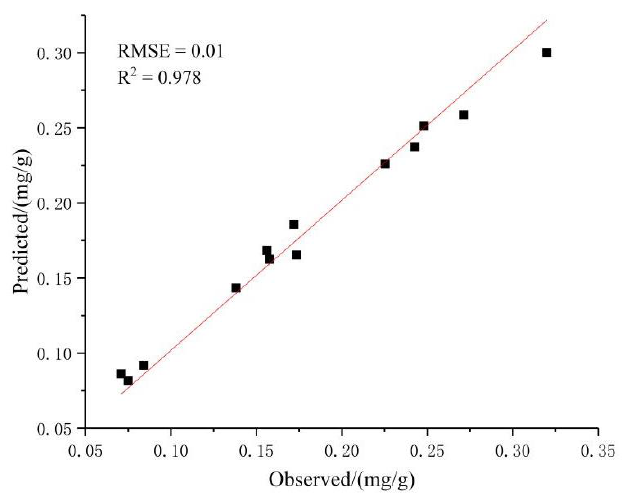
Figure 4. Relationships between observed and predicted values of chlorophyll content in the pericarp of fragrant pears by the generalized regression neural network (GRNN)